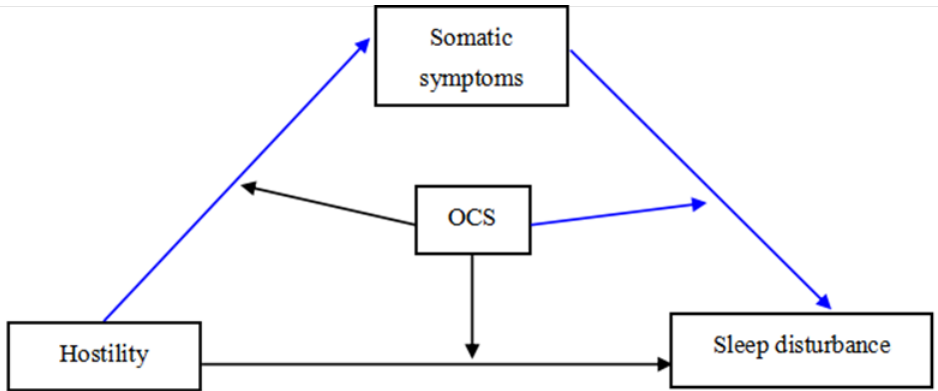
Figure 1. Diagram of the theoretical moderated mediation model.